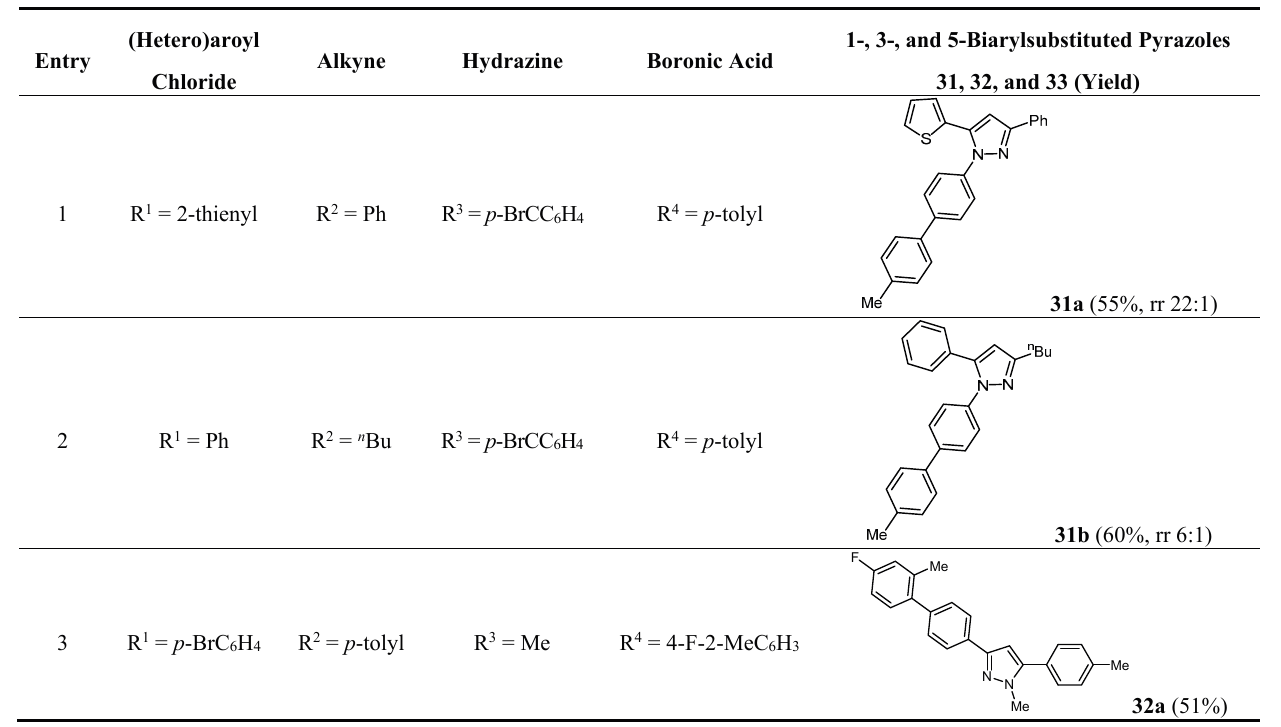
Table 11. Selected 1-, 3-, and 5-biarylsubstituted pyrazoles 31 , 32 , and 33 via